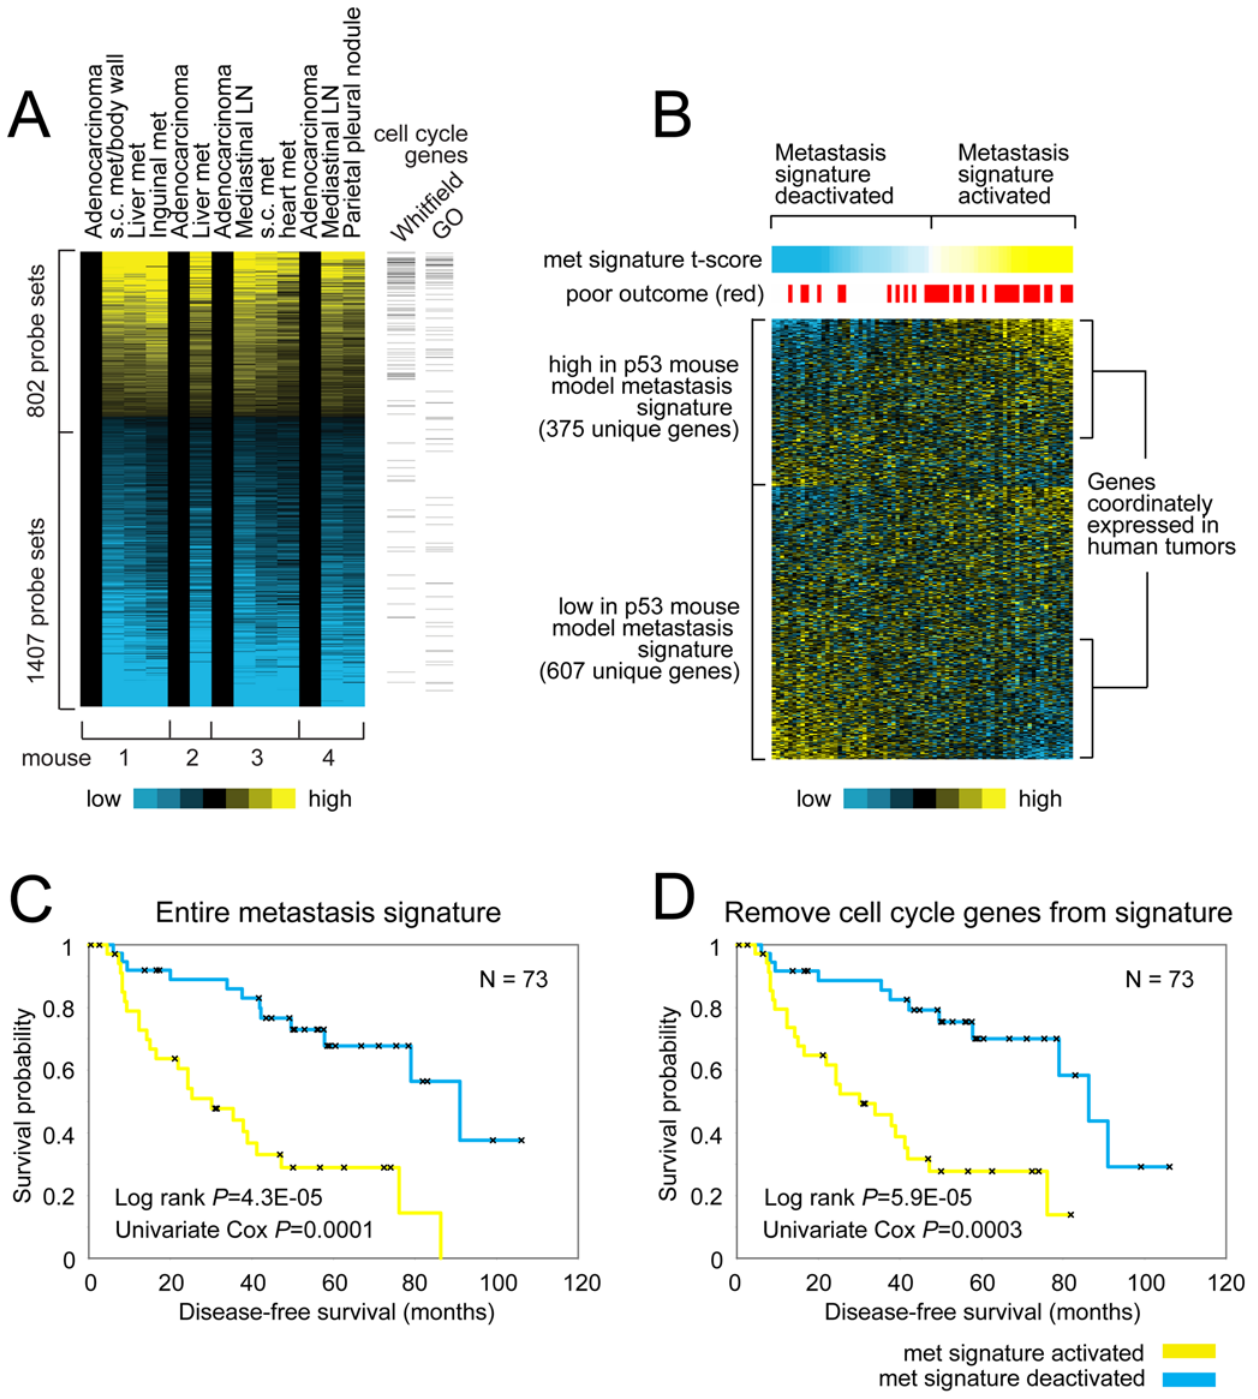
Figure 1. A gene expression signature of spontaneous metastasis in a K-ras/p53 mutant mouse model. (A) Gene expression profiles of tumor metastases were compared to the corresponding primary tumor to define the metastasis gene signature (P , 0.01, paired t-test). Each row of the expression matrix represents a gene and each column represents a profiled sample; relative gene expression (metastasis: primary) is represented using a yellow–blue color scale. Genes defined as cell cycle-related by either the Whitfield signature [16] or by Gene Ontology (GO) are indicated. (B) The expression patterns of the mouse model metastasis signature in a panel of human lung tumors from Bhattacharjee et al. [14]. Tumors showing ‘‘activation’’ of the metastasis signature (as measured by the ‘‘met signature t-score’’) tend to have high expression of the genes high in the mouse metastases and low expression of the genes low in the mouse metastases. (C) Kaplan-Meier analysis of the human lung tumors comparing the differences in risk between tumors showing activation (yellow line, t-score . 0) and tumors showing deactivation (blue line, t-score , 0) of the mouse model metastasis signature. Log rank test evaluates whether there are significant differences between the two arms. Univariate Cox test evaluates the association of the met signature t-score with patient outcome, treating the coefficient as a continuous variable. (D) Same as for part C, except that cell cycle-associated genes (as defined by either Whitfield et al or GO) were first removed from the mouse model metastasis signature prior to deriving the met signature t-score.